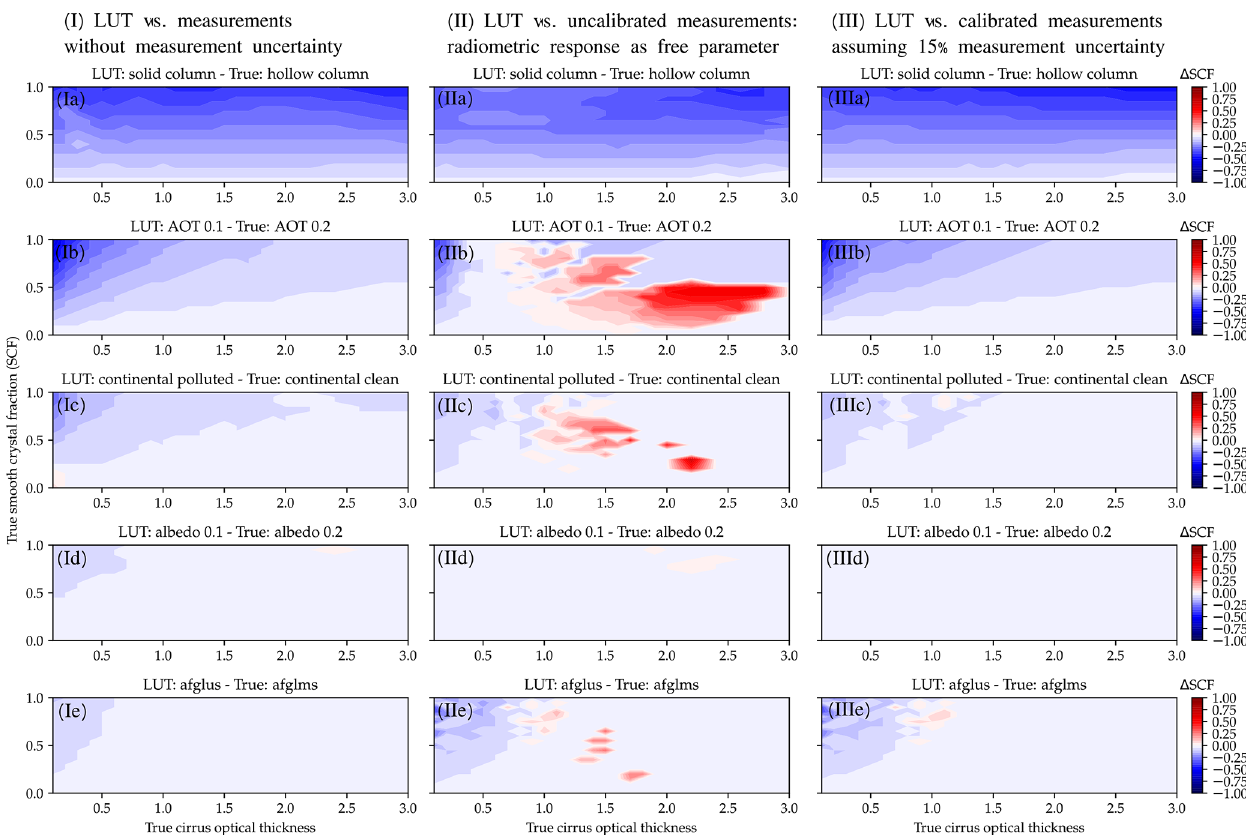
Figure B1. Sensitivity of the retrieval regarding five different LUT parameters: (a) ice crystal habit, (b) AOT, (c) aerosol type, (d) surface albedo, and (e) atmospheric profile. Three different scenarios were investigated: (I) assuming “perfect” measurements without calibration uncertainty; (II) assuming uncalibrated measurements by treating the radiometric response as a free scaling parameter during the retrieval; (III) calibrated measurements with an uncertainty of 15%. To test the sensitivity, a LUT was matched against synthetic measurements simulated with DISORT at a wavelength of 500nm and an SZA of 45 ◦ in the almucantar plane. Synthetic measurements for different COTs and SCFs were calculated and are considered “truth”. The LUTs were calculated for slightly different parameter values or parameterizations for the different tests (a–e) , while all other LUT parameters were correct. Panels (a) – (e) show contour plots of the difference between the true and retrieved smooth crystal fraction (cid:49) SCF = SCF Retrieved − SCF True . Blue indicates an underestimation (SCF Retrieved < SCF True ) and red an overestimation (SCF Retrieved > SCF True ) of the true SCF.